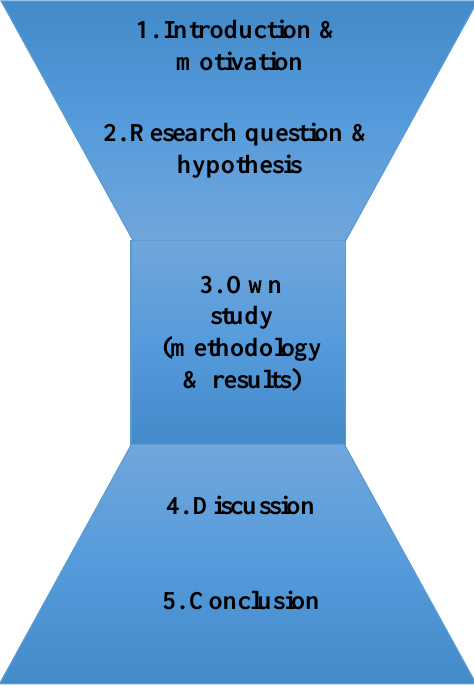
Figure 5. The hourglass shape of an empirical research paper (based on Bem